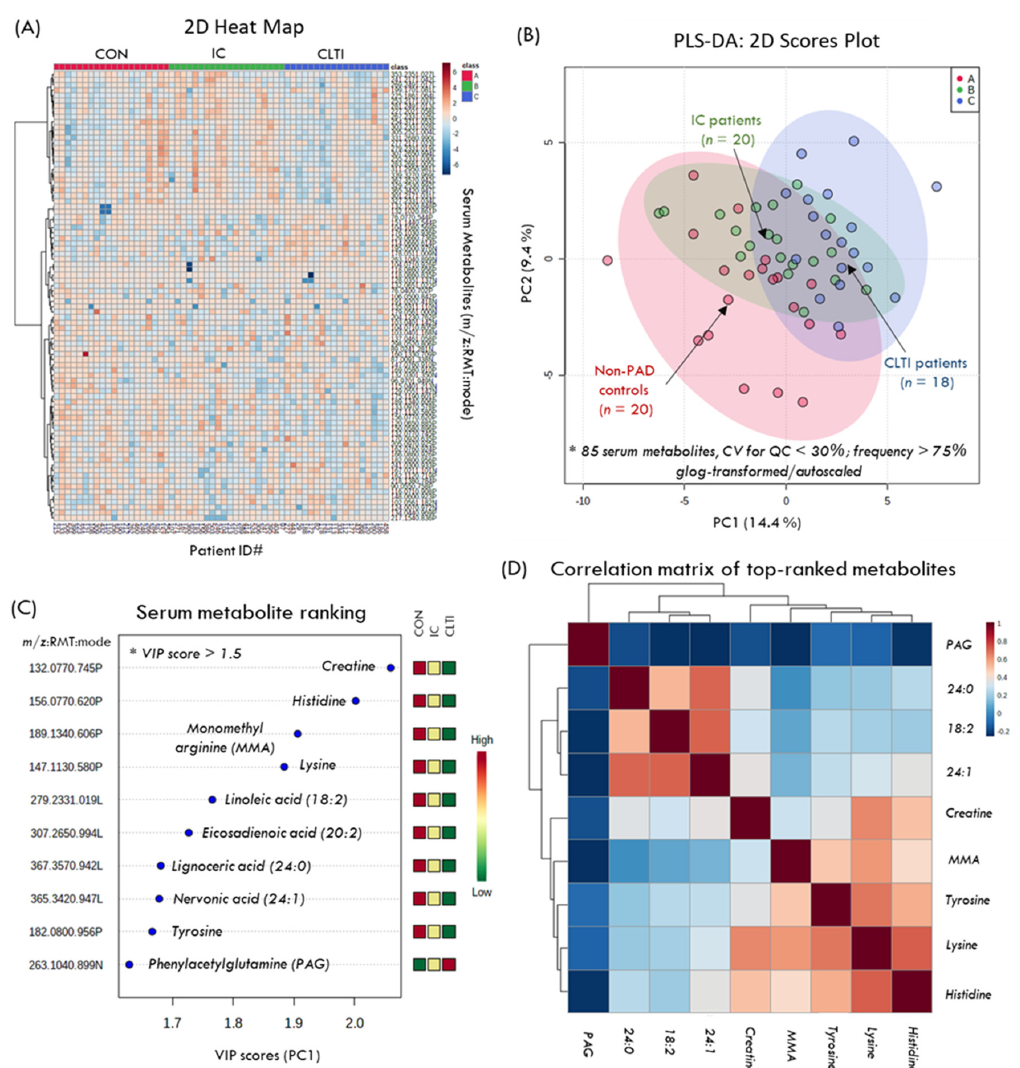
Figure 3. ( A ) Two-dimensional heat map of the serum metabolome of PAD patient sub-groups (IC, CLTI) and non-PAD controls (CON) that summarizes the overall data structure of this study. ( B ) Two-dimensional scores plot using a partial least-square discriminant analysis (PLS-DA) model to di ff erentiate the metabolic phenotype of late-stage CLTI ( n = 18) from early onset IC ( n = 20) cases as compared to age and sex-matched CON ( n = 20) based on 85 serum metabolites / lipids. ( C ) Ten top-ranked serum metabolites that di ff erentiate PAD patients and non-PAD controls based on a variable importance in projection (VIP scores > 1.5). ( D ) Correlation matrix depicts two main clusters of circulating metabolites associated with PAD, including circulating amino acids / amines strongly correlated ( r ~0.70) to lysine (histidine, tyrosine, MMA: monomethylarginine, and creatine), as well as long-chain fatty acids (18:2, 20:2, 24:0, 24:1) unlike serum phenylacetylglutamine (PAG).